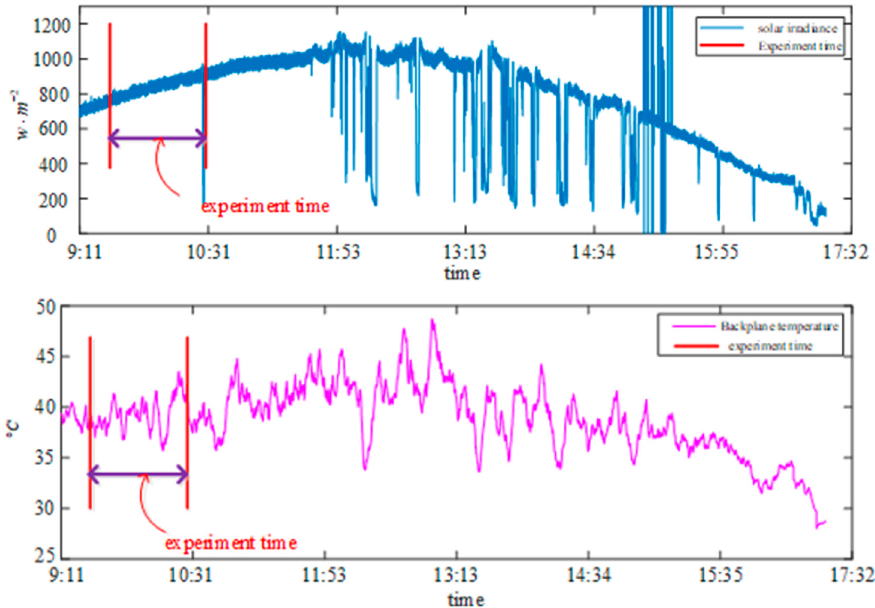
Figure 8. The solar irradiance and temperature range in the whole day on 7 September 2018.